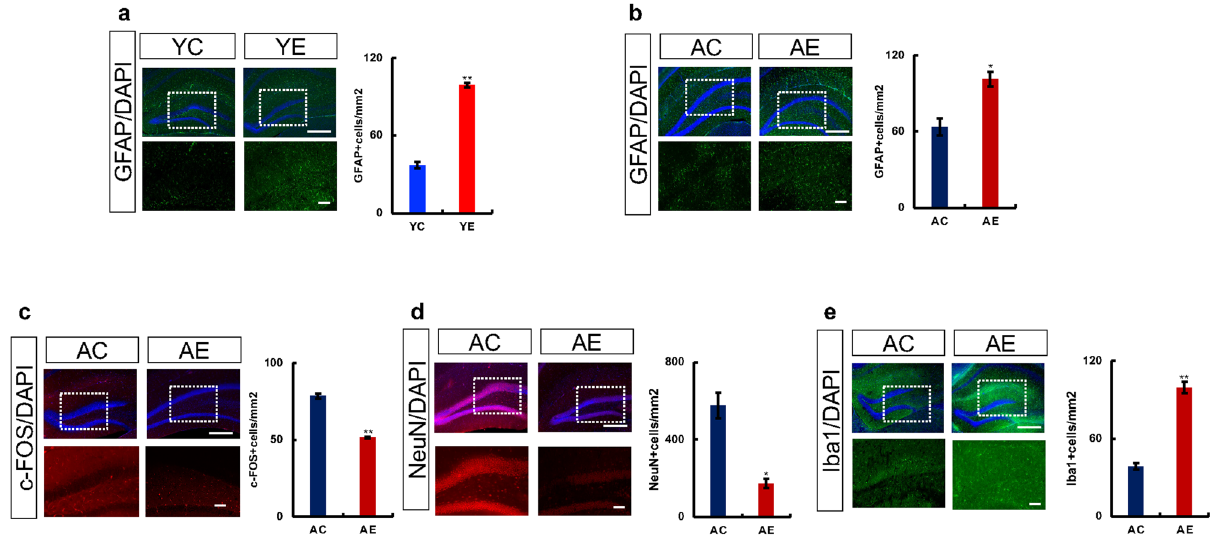
Figure 4. Effects of maxillary molar loss on protein expression in the hippocampus of mice (Immunostaining). Astrogliosis is induced in the hippocampus of mice with missing molars. The hippocampus and protein expression are shown. The square made by the dotted line is the CA1 region of the hippocampus, shown enlarged below. ( a ) Typical GFAP-positive cell area (mm 2 ) and graphs showing the hippocampus of control and extraction groups of young mice (YC3 vs. YE3). ( b–e ) Typical staining images and graphs showing the hippocampus of control and extraction groups of aged mice (AC3 vs. AE3); ( b ) GFAP, ( c ) c-FOS, ( d ) NeuN, ( e ) Iba-1. The number of c-FOS- and NeuN-positive cells were increased, and c-FOS and NeuN positive cells were decreased upon tooth extraction. Scale bar: 100